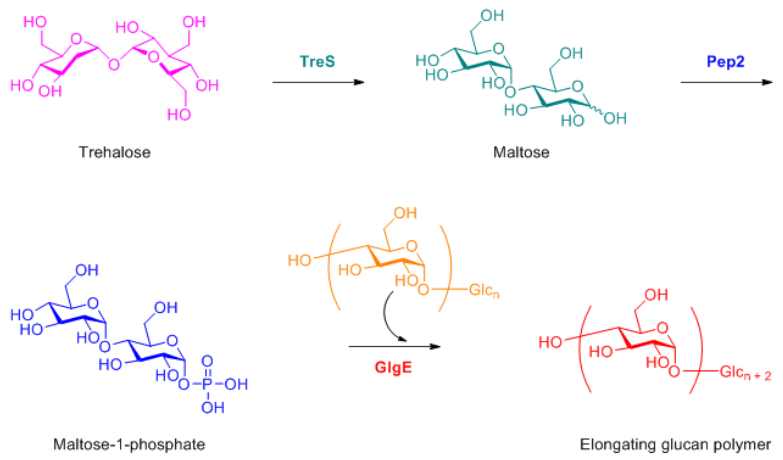
Figure 3. Biosynthetic pathway of α-1,4-glucan elongation via, TreS, Pep2 and GlgE [217-220].